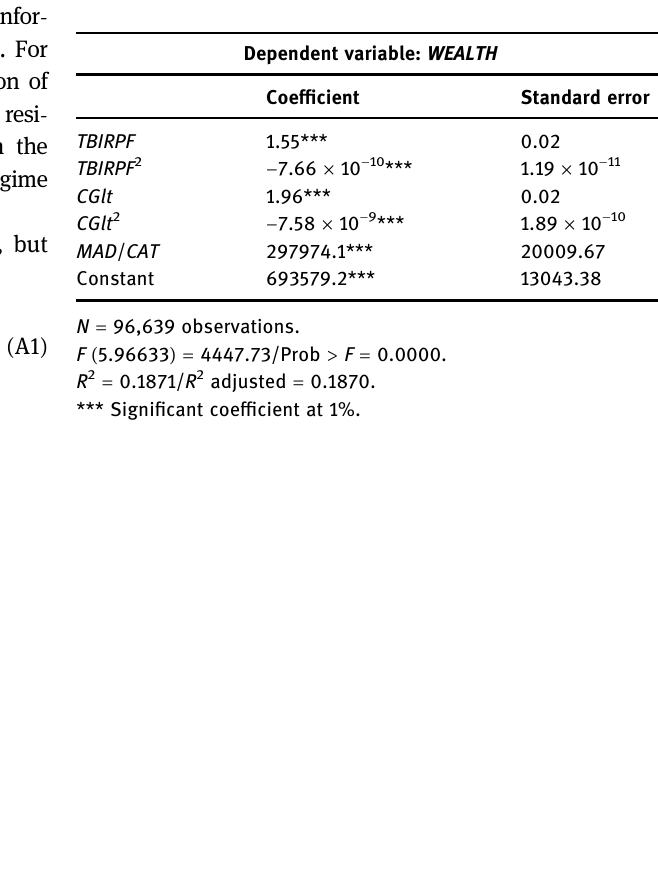
Table A1: Results of the OLS estimate of individual wealth through the information in the wealth tax